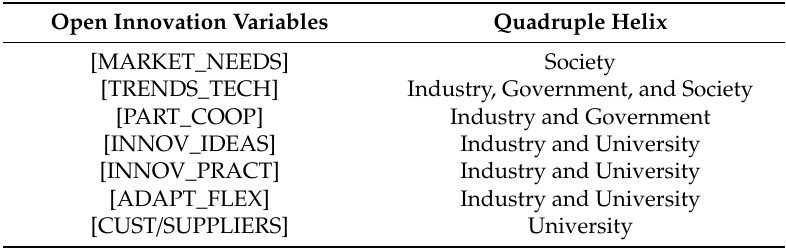
Table 9. Relationship of open innovation variables with quadruple